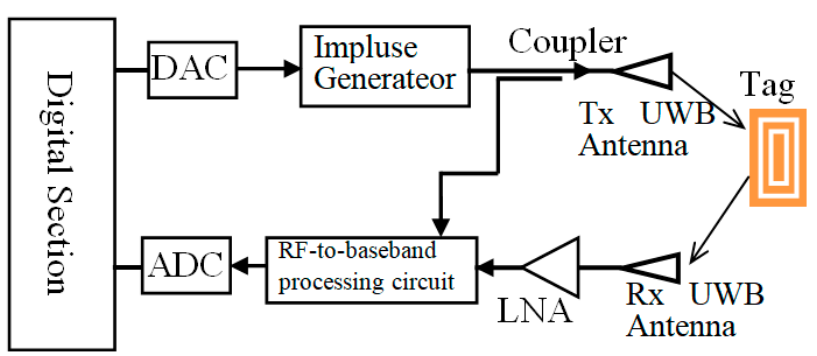
Figure 18. Block diagram of the chipless reader.